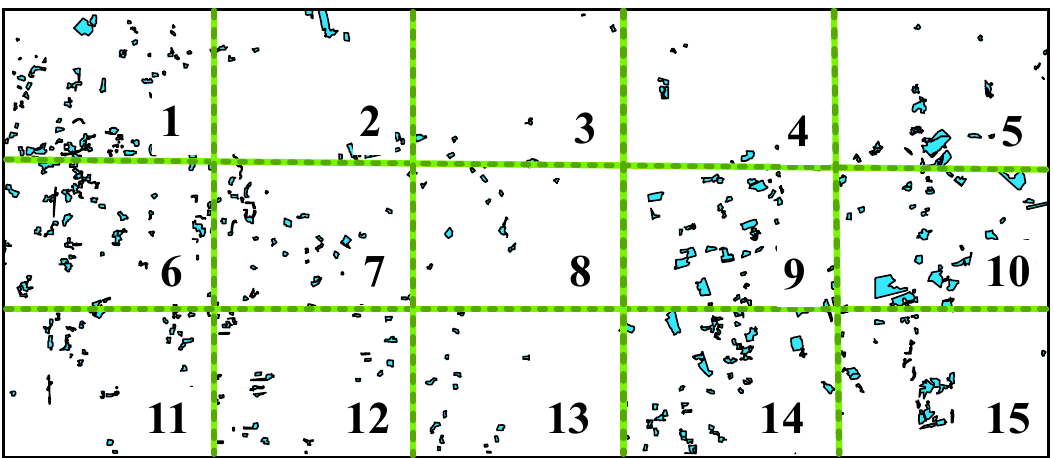
Figure 7. Distribution of the Amazon database. The region was divided into fifteen tiles. Four tiles were used for training (1, 7, 9, 13) and two for validation (5, 12). The remaining tiles were used for